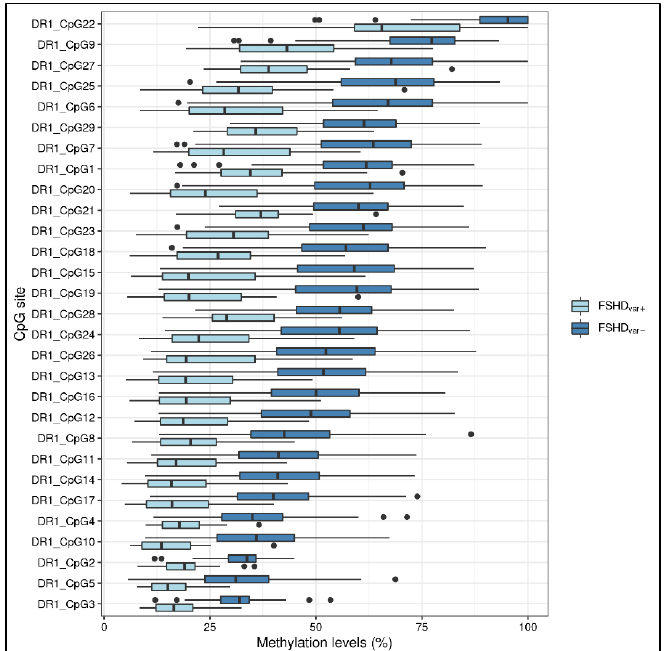
Figure 4. A boxplot showing the methylation levels related to the DR1 CpG sites of FSHDvar+ ( n = 15) and FSHDvar − ( n = 118) . The lower and upper hinges correspond to the 25th and 75th percentiles of the distribution. The whiskers extend from the hinge to the largest value no further than ±1.5 × IQR (where IQR is the inter-quartile range, namely distance between the first and third quartiles). Data points beyond the whiskers are plotted individually.